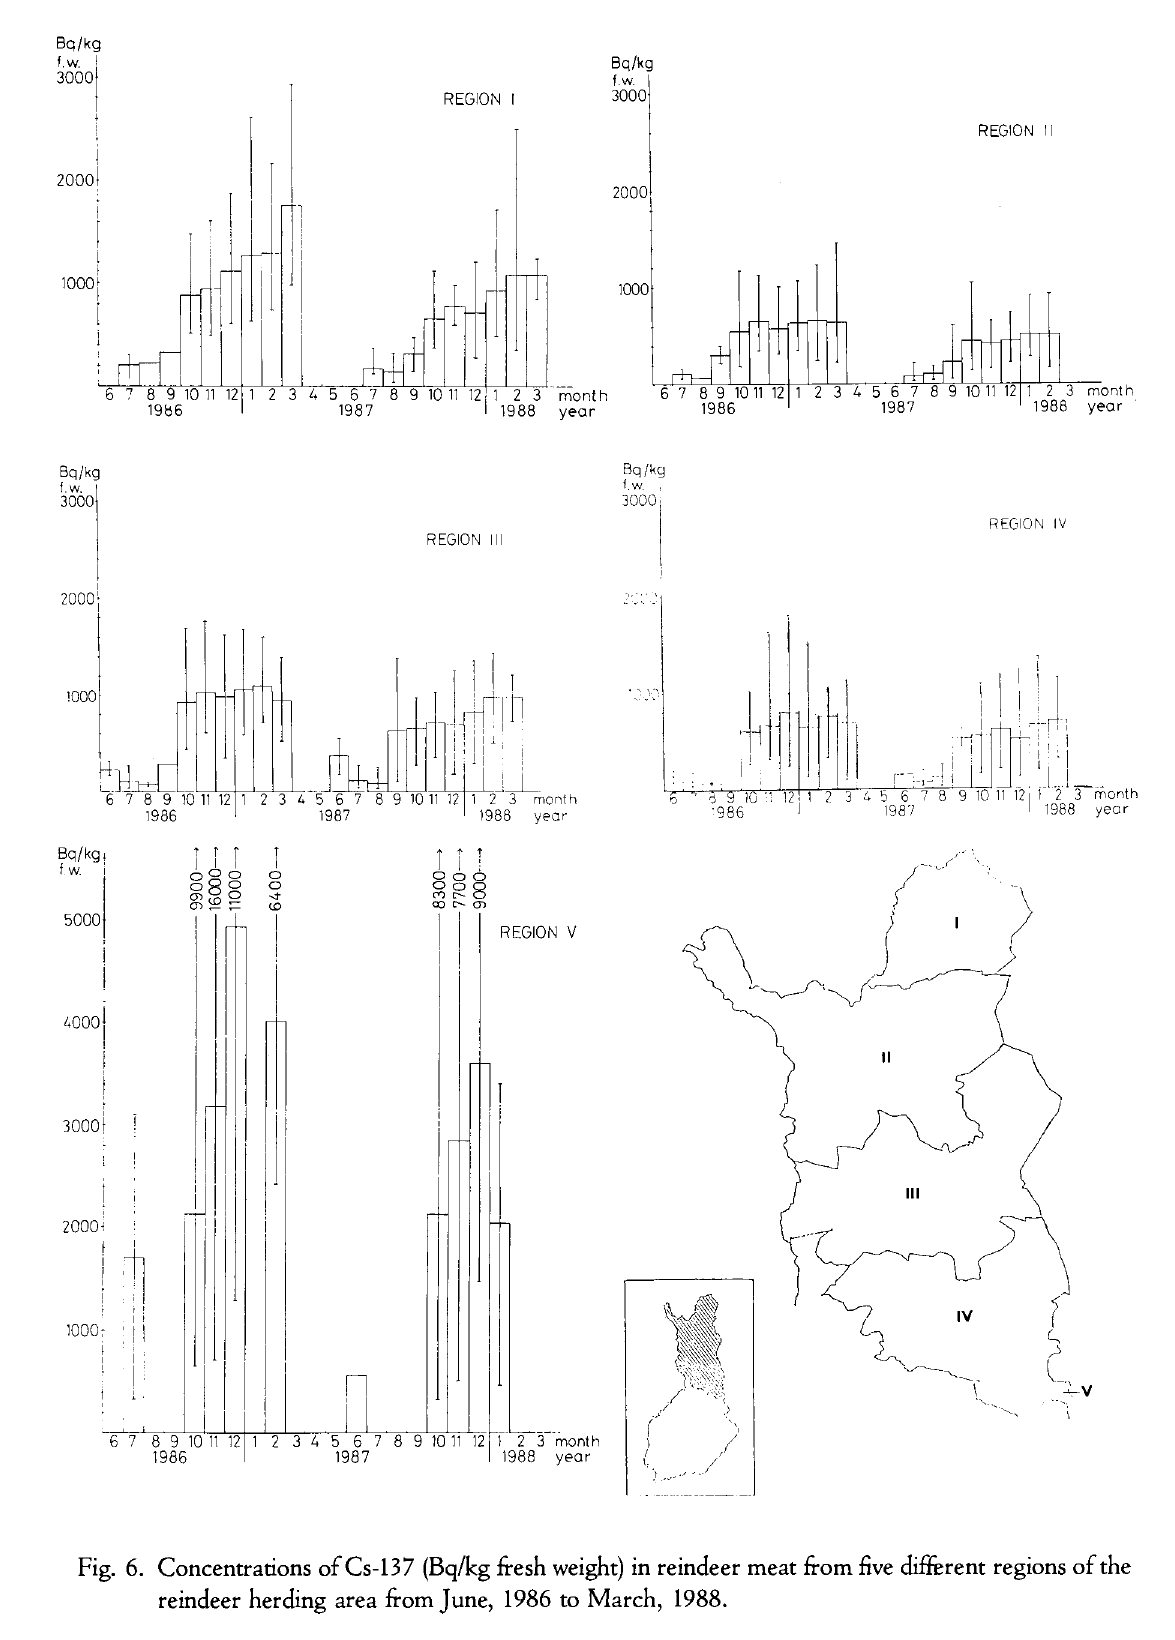
Fig. 6. Concentrations of Cs-137 (Bq/kg fresh weight) in reindeer meat from five different regions of the reindeer herding area from June, 1986 to March,